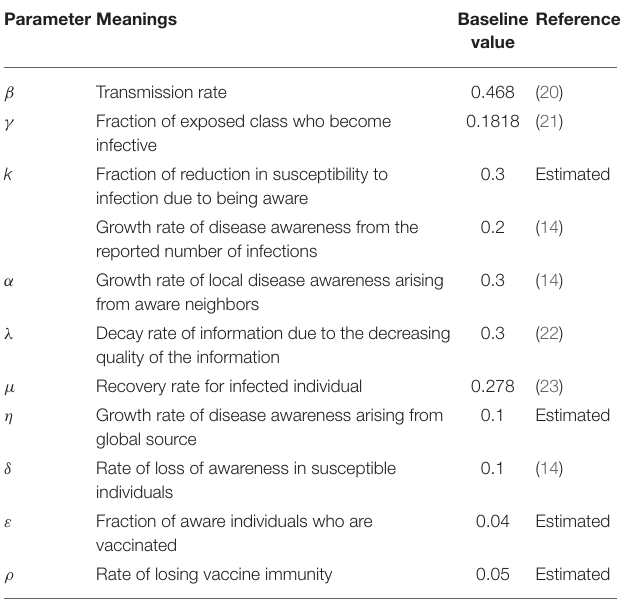
FIGURE 1 | Schematic of SEIRM/V dynamics in multilayer networks. TABLE 1 | Description and baseline values of the parameters of model